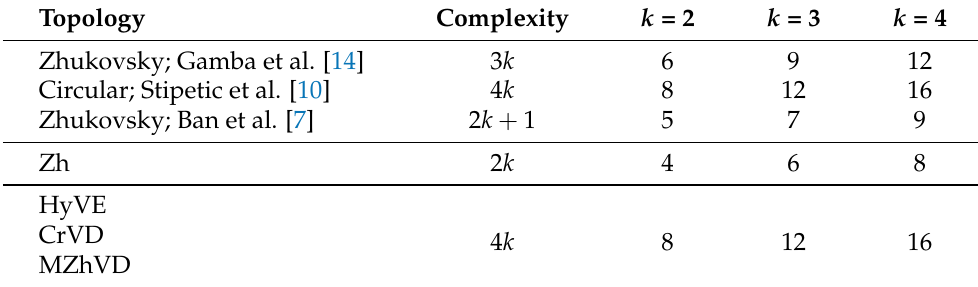
Table 4. Parametric